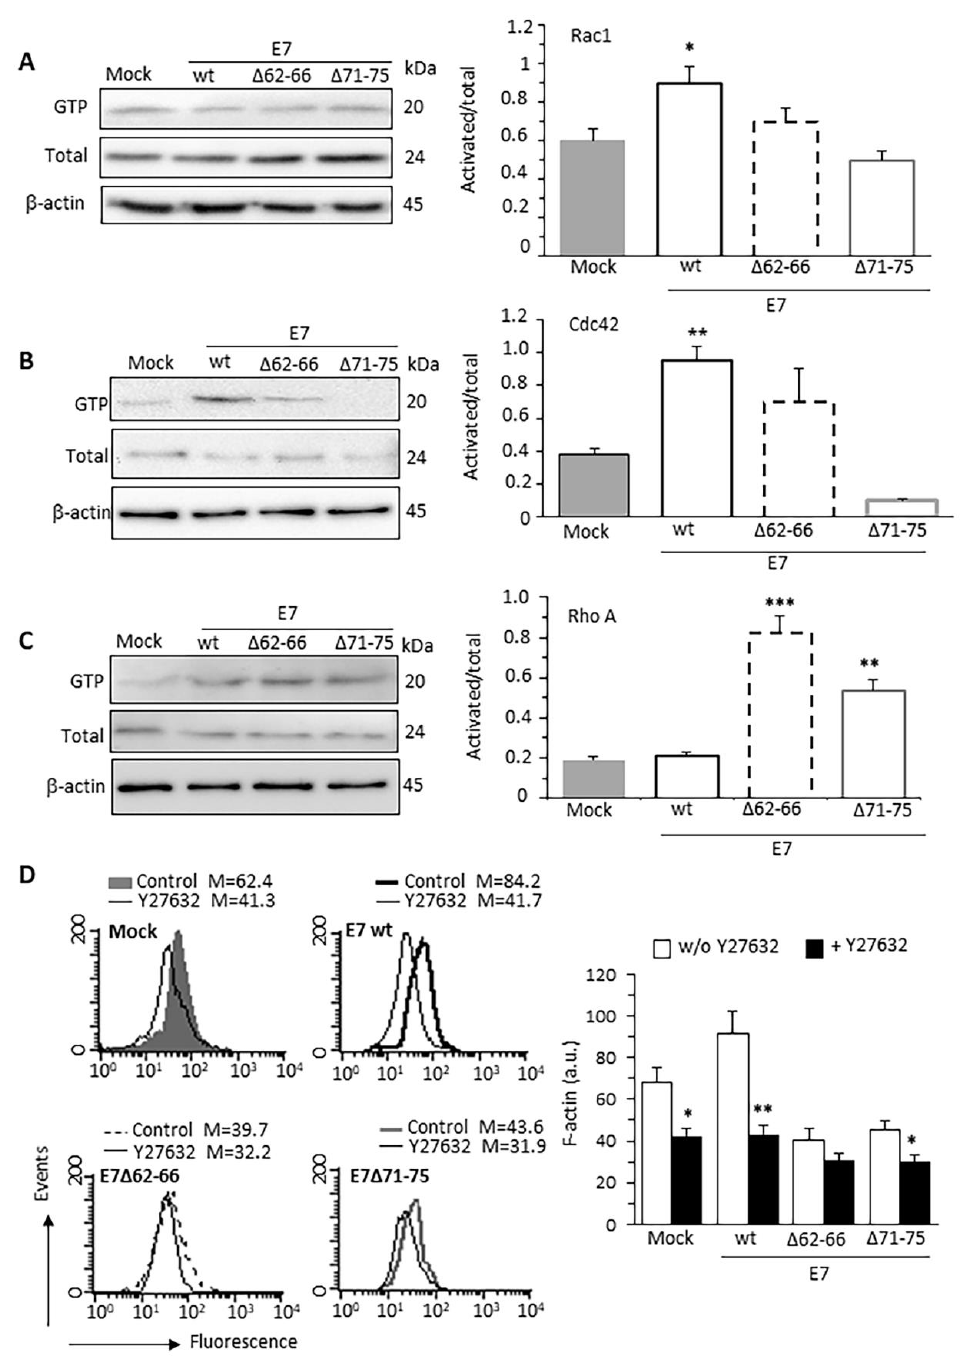
Figure 2. HPV16E7 expression induces activation of Rac1 and Cdc42 GTPases. Activation state of RhoGTPases measured by pull-down assays using PBD domain of PAK for Rac1 ( A ) or Cdc42 ( B ), and the RBD domain of Rhotekin for RhoA ( C ), followed by immunoblotting with the respective antibodies. In addition, Rac1, Cdc42, or RhoA from total lysates were quantified (left panels). In the right panels, bar graph shows the active forms of Rac1, Cdc42, and RhoA GTP (GTP-bound levels/total levels) normalized to β-actin. The mean ± SD of the results obtained in three independent experiments is shown. * p < 0.05, ** p < 0.1 and *** p < 0.001 vs Mock transfected cells. ( D ) Flow cytometry evaluation of the intracellular amount of F-actin, restricted to pAmCyan-positive cells, before or after treatment with the RhoGTPase inhibitor Y27632 (15 µM for 40 min). Bar graph (right) reports results as mean ± SD of the median fluorescence intensity obtained in three different experiments. * p < 0.05 and ** p < 0.01, vs the same sample treated with Y27632. Uncropped western blot images for Figure 2A–C available in Supplementary Figure